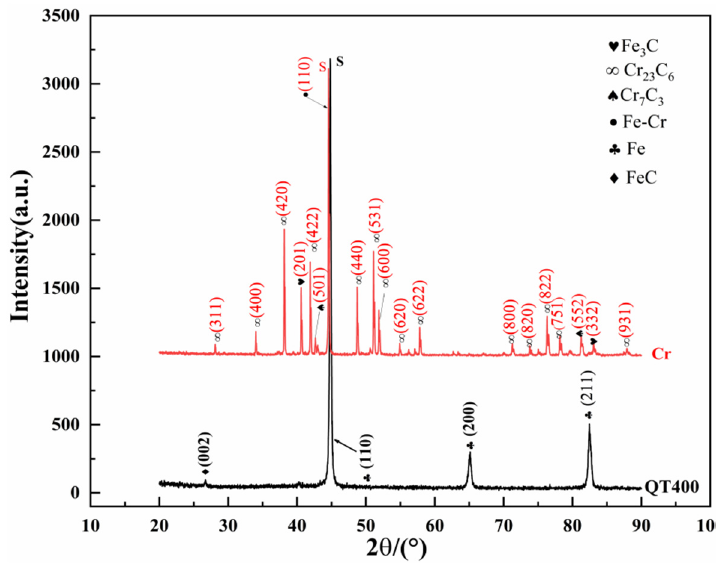
Figure 3. X-ray diffraction patterns of chrome-coated and original QT400 samples.